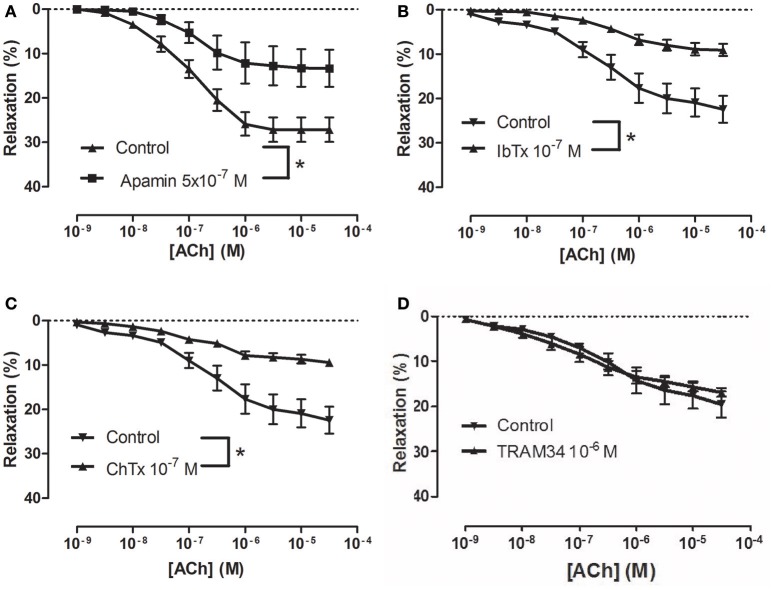
Involvement of apamin- and iberiotoxin-sensitive channels in acetylcholine (ACh) relaxation of rat corpus cavernosum (CC). Concentration-response curves for ACh in the absence and the presence of (A) control (n = 13) vs. apamin (0.5 μM) (n = 6), (B) control (n = 8) vs. iberiotoxin (0.1 μM) (n = 9), (C) control (n = 8) vs. charybdotoxin (0.1 μM) (n = 10), and (D) control (n = 8) vs. TRAM-34 (1 μM) (n = 9). Data are expressed as means ± S.E.M. *P ≤ 0.05, curves were significantly different, two-way ANOVA followed by a Bonferroni post-test.